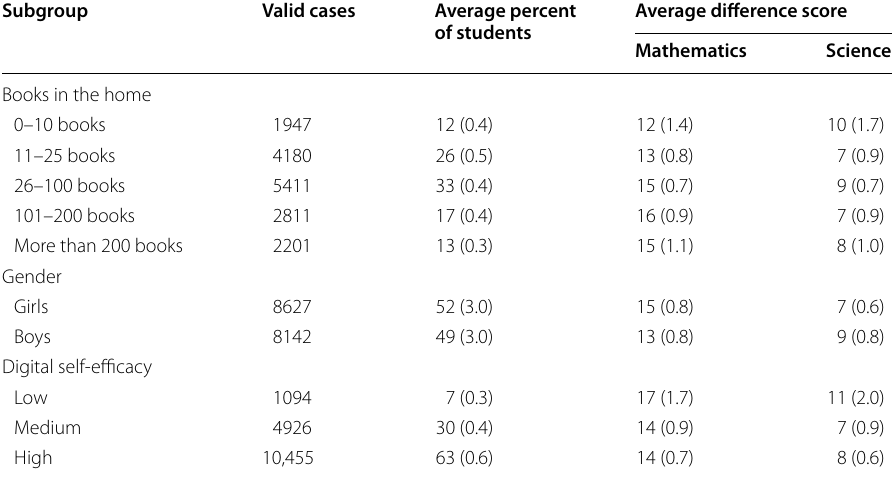
Table 8 Average paperTIMSS-eTIMSS difference scores by student subgroups—fourth grade